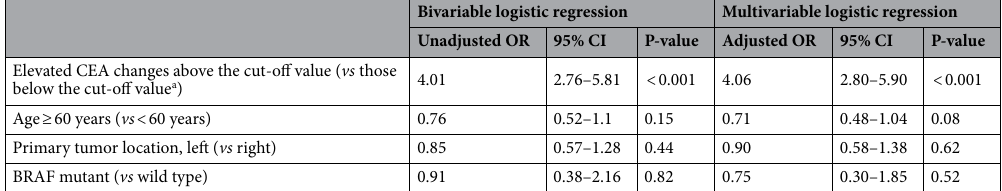
Table 3. Bivariable and multivariable regression analyses of prediction of progression in the whole cohort (n = 1109). OR, odds ratio; CI, confidence interval. a Cut-off value: CEA increase ≥ 16.5%.